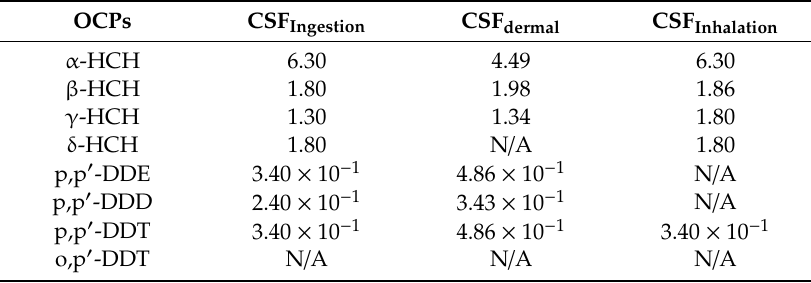
Table 1. The parameters used in calculating the incremental cancer risk (ILCR) for humans exposed to environmental pollutants. OCPs CSF Ingestion CSF dermal CSF Inhalation α -HCH 6.30 4.49 6.30 β -HCH 1.80 1.98 1.86 γ -HCH 1.30 1.34 1.80 δ -HCH 1.80 N / A 1.80 p,p (cid:48) -DDE 3.40 × 10 − 1 4.86 × 10 −